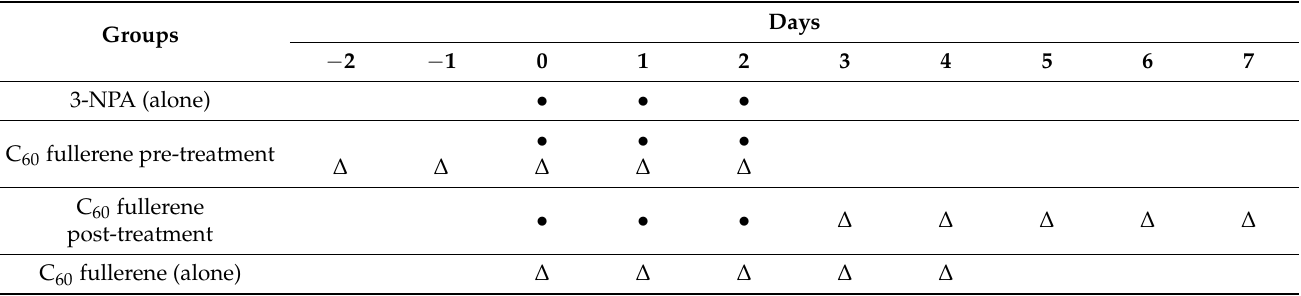
Table 2. Experimental protocol used for 3-NPA and C 60 fullerene